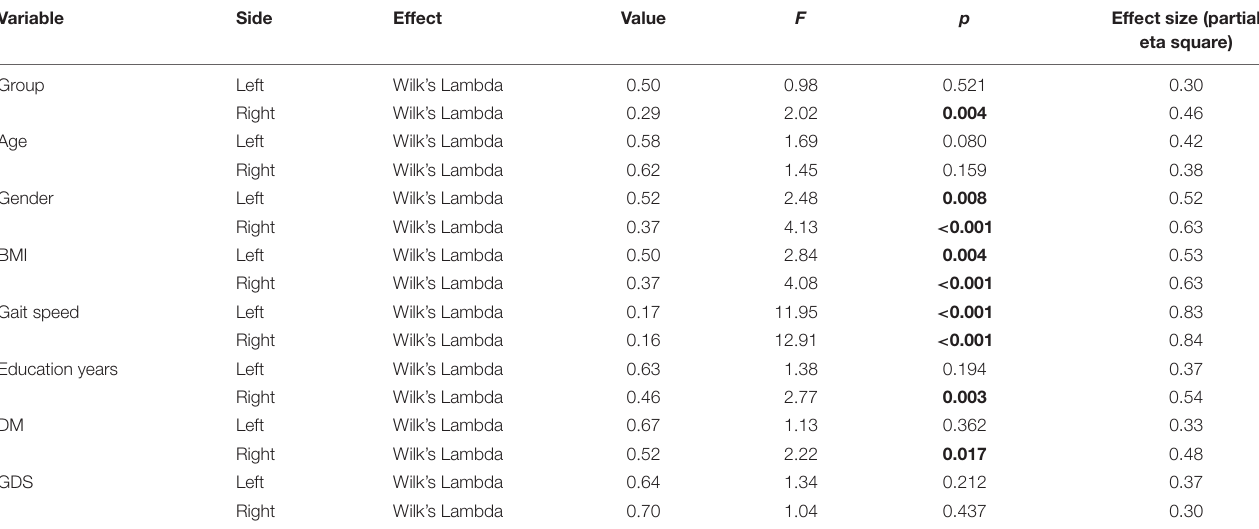
TABLE 2 | Multivariate analysis of covariances of various covariates (left and right